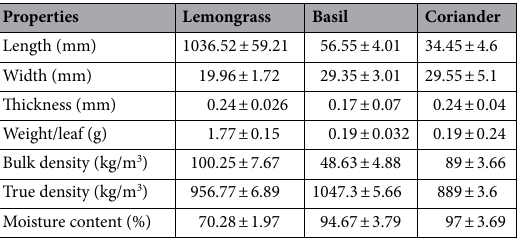
Table 1. Measurement of physical parameters/properties of leaves of selected plant spp.